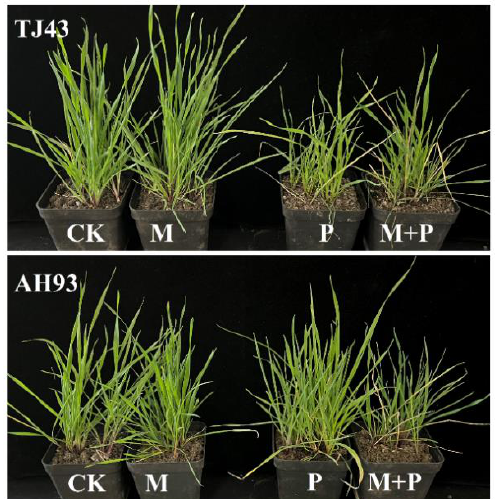
Figure 2. The resistant (AH93) and susceptible (TJ43) black grass plants 21 days after pyroxsulam treatment with or without malathion. CK, untreated; M, malathion (1000 g ai ha −1 ) treatment; P, pyroxsulam (12.6 g ai ha −1 ) treatment; M + P, malathion (1000 g ai ha −1 ) plus pyroxsulam (12.6 g ai ha −1 ) treatment.